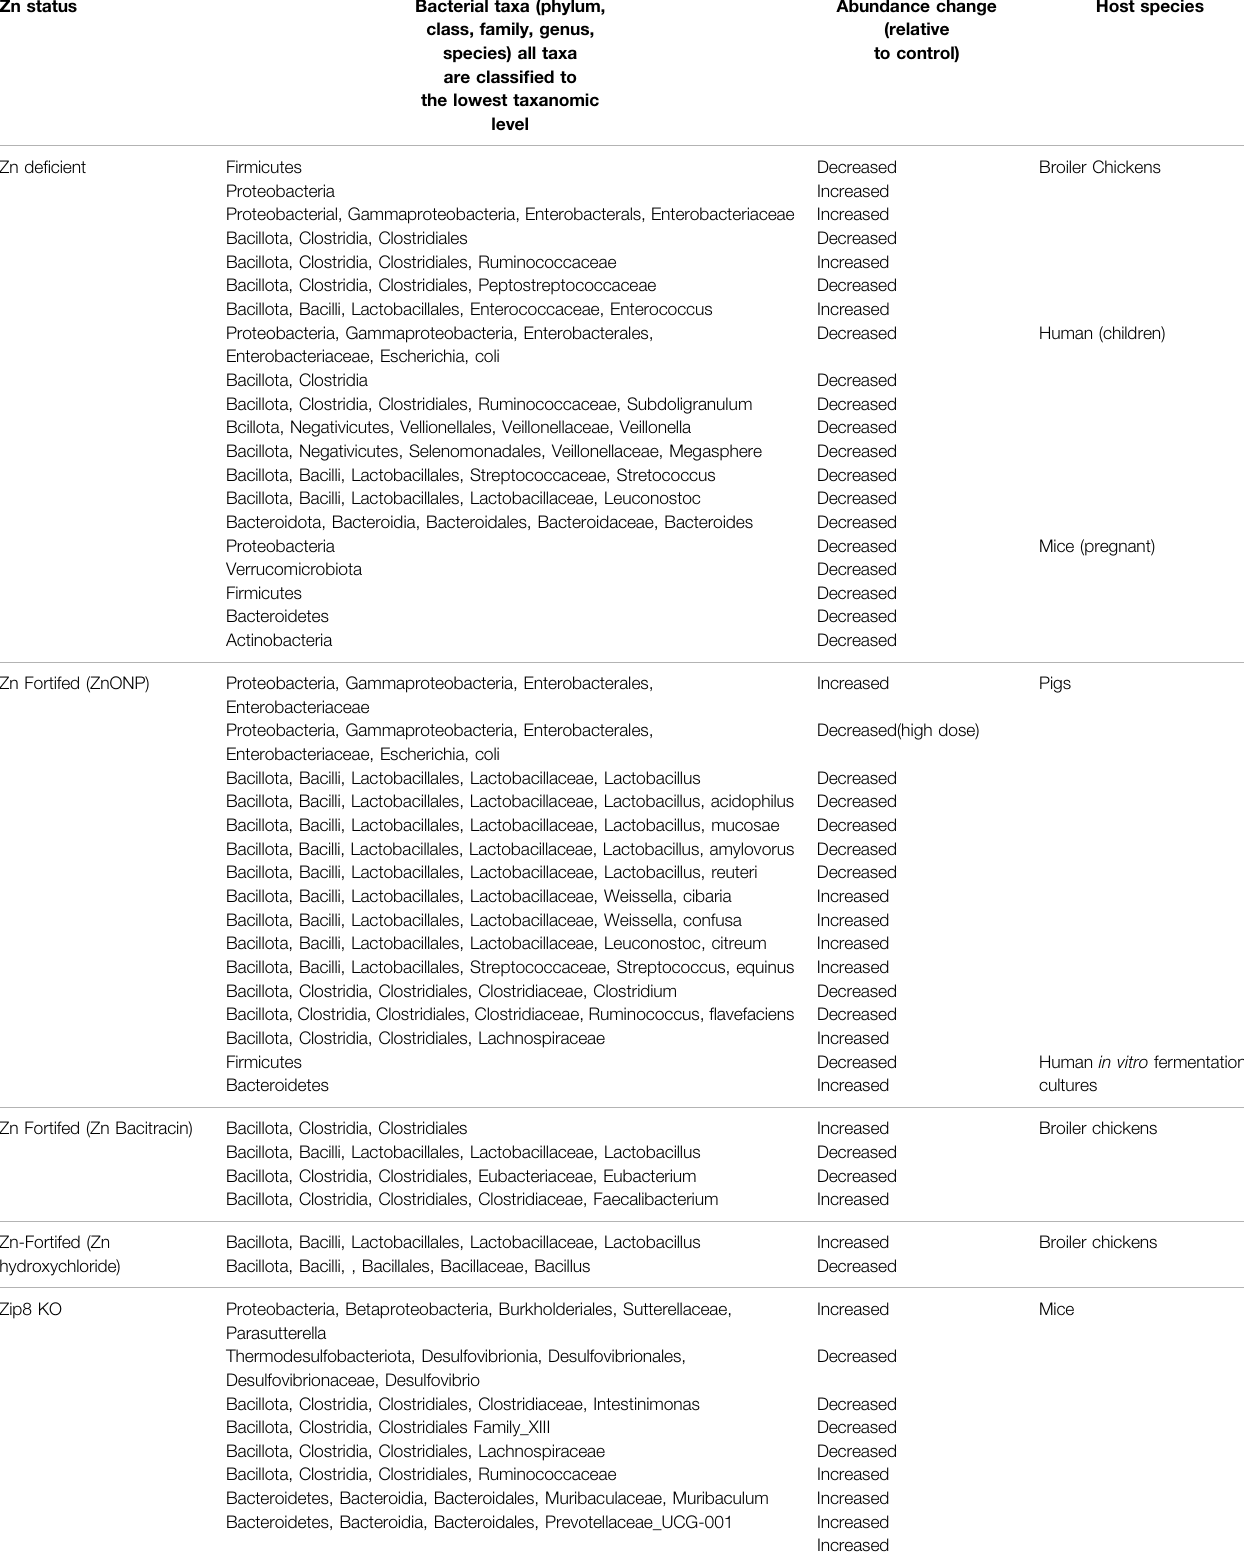
TABLE 2 | Effects of ZN and Zn-transporters on the intestinal microbiota composition. Zn